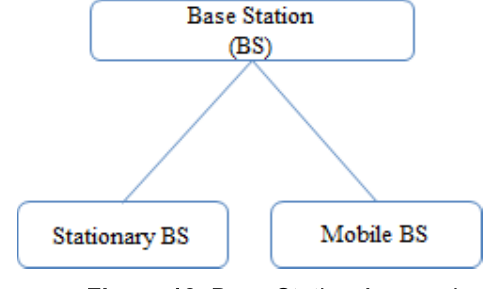
Figure 13. Base Station